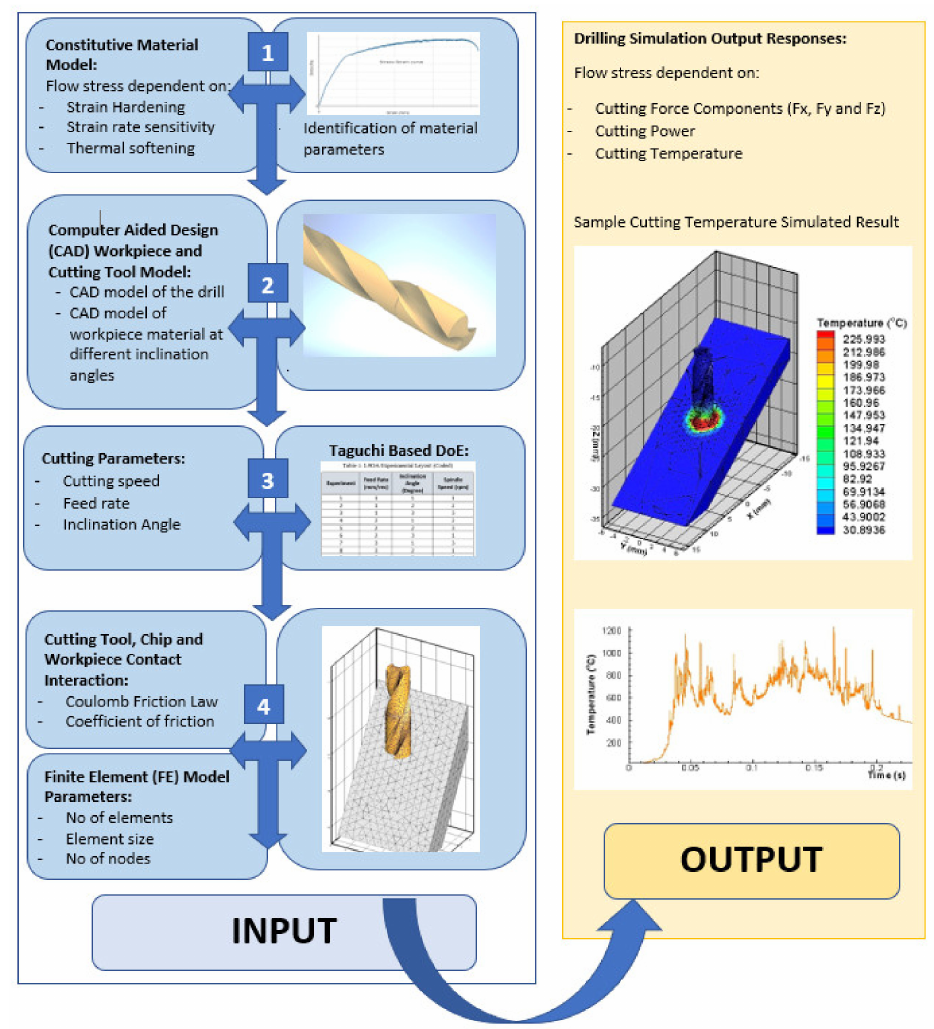
Figure 2. Flow chart of 3D Finite Element (FE) drilling model at various inclination